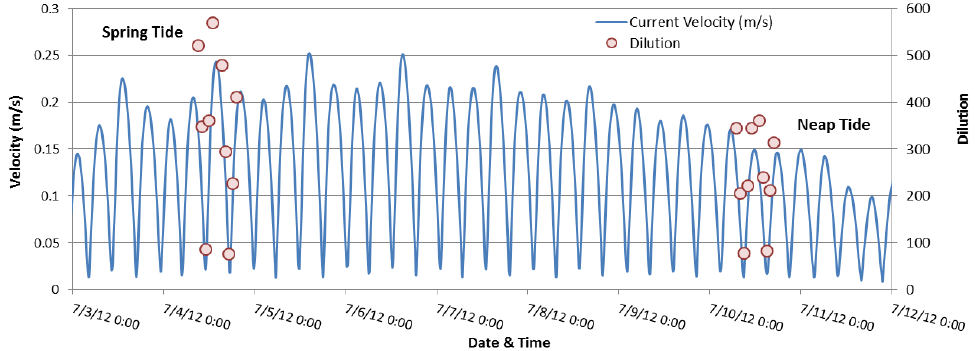
Figure 6. Variation of dilution over the spring-neap tidal cycle for Case 1.